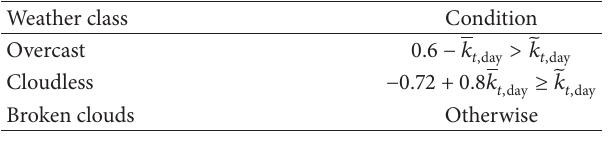
Table 1: Overview of the three weather classes and their detection conditions.